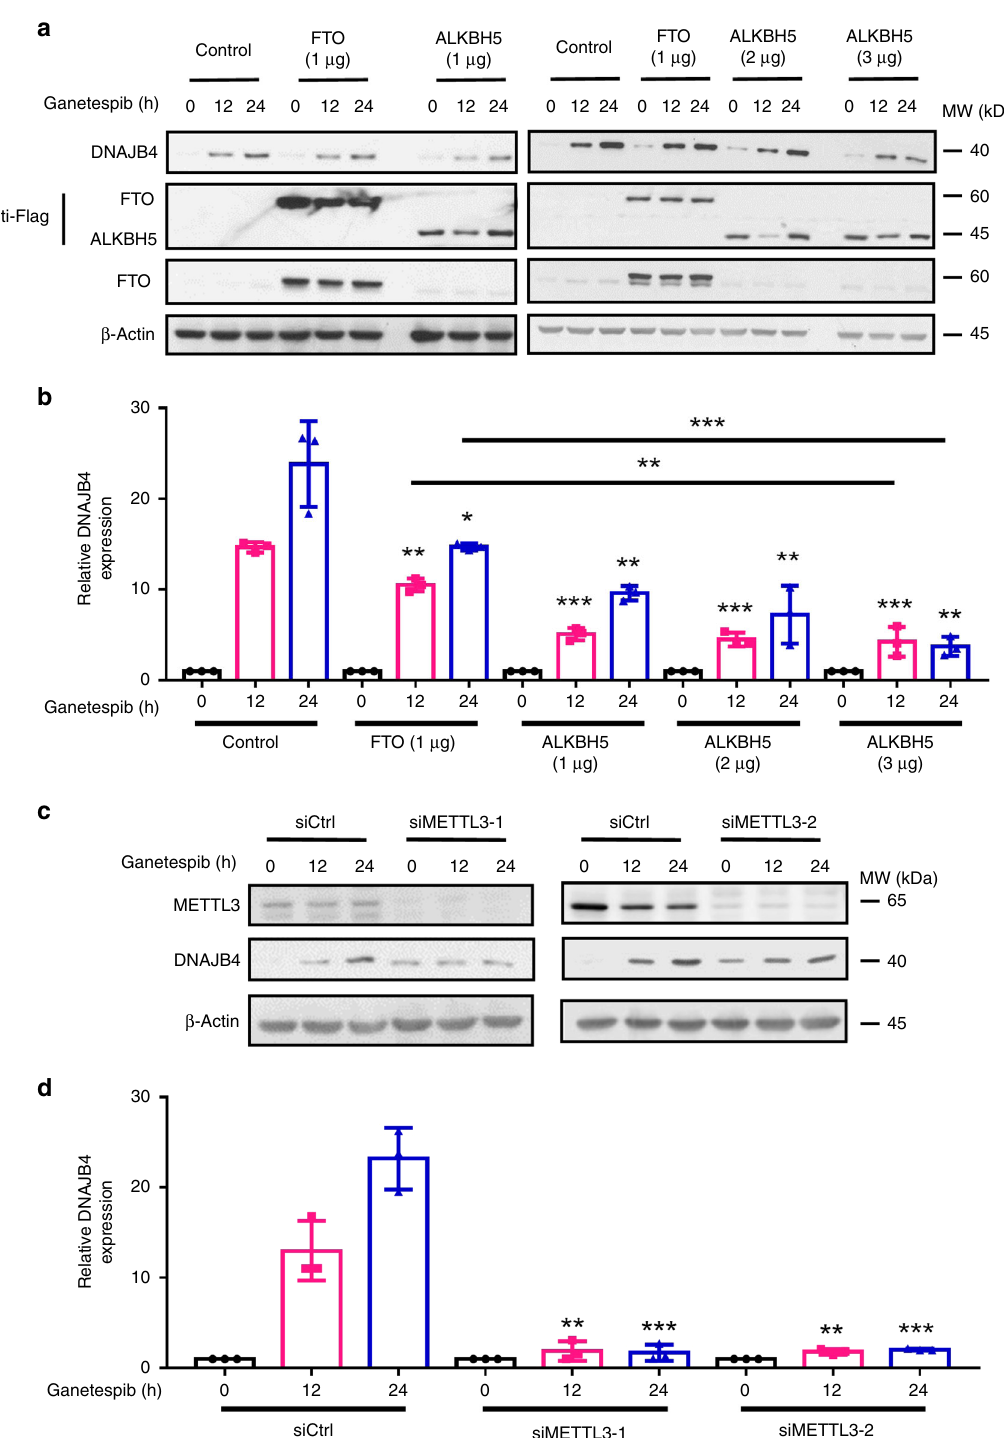
Fig. 4 Modulation of DNAJB4 protein level by m 6 A writer and erasers. a Western blot for monitoring the expression levels of DNAJB4, Flag-tagged FTO, and ALKBH5, and endogenous FTO in M14 cells transfected with control plasmid or plasmids for the ectopic expression of Flag-FTO or ALKBH5 at different time intervals following treatment with 100 nM ganetespib. b Quanti fi cation data based on western blot analysis in ( a ). c Western blot for monitoring the expression levels of DNAJB4 in M14 cells treated with control non-targeting siRNA (siCtrl), siMETTL3 – 1 or siMETTL3 – 2 at different time points following treatment with 100 nM ganetespib. d Quanti fi cation data based on western blot analysis in ( c ). β -actin was employed as the loading control in ( a ) and ( c ). Shown in ( b ) and ( d ) are the ratios of expression of DNAJB4 protein over β -actin, and further normalized to the ratios obtained for the control cells without ganetespib treatment. The quanti fi cation data in ( b ) and ( d ) represent the mean ± S. D. of results from three independent experiments. The p- values referred to comparisons between control cells and cells with ectopic overexpression of the indicated genes ( b ), or between controls and siRNA-mediated knockdown of the indicated genes ( d ). The p -values were calculated using unpaired, two-tailed Student ’ s t -test: # p > 0.05; *, 0.01 ≤ p < 0.05; **, 0.001 ≤ p < 0.01; ***, p < 0.001. Source data are provided as a Source Data fi